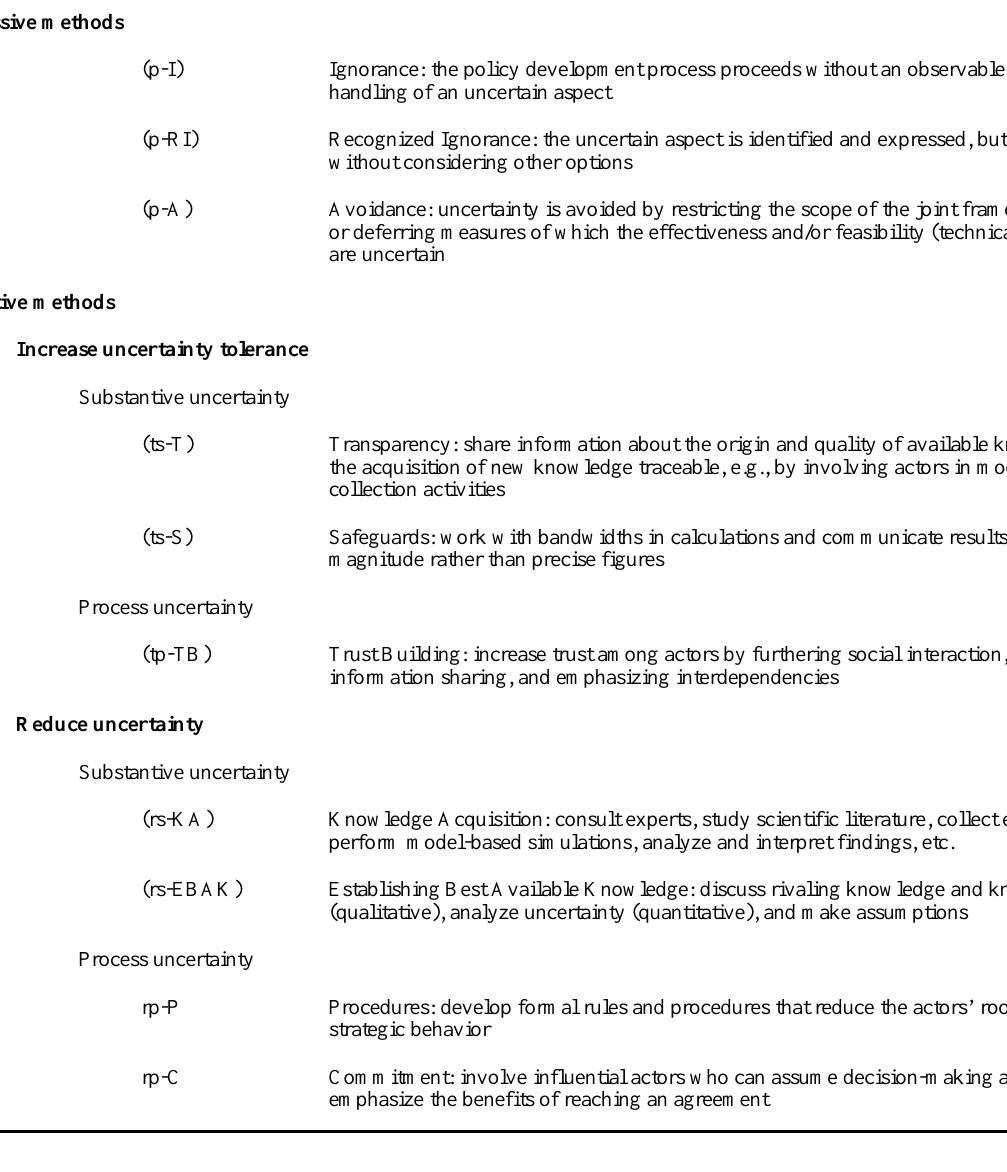
Table 1 . Methods for handling